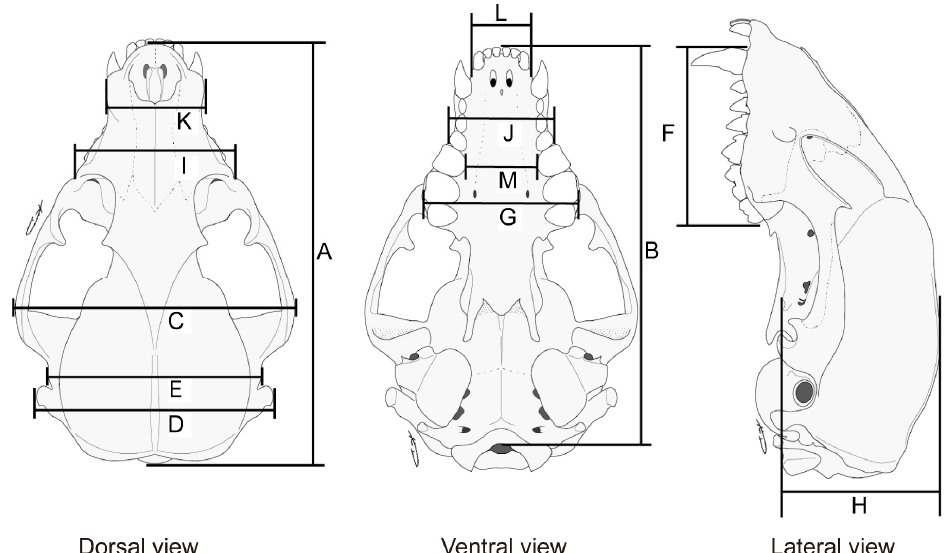
Figure 1. Lateral, ventral, and dorsal craniometrics of the raccoon ( Procyon lotor ) skull. A: greatest length of skull (GLS), B: basal length (BaL), C: zygomatic width (ZW), D: paraoccipital width (PW), E: cranial width (CW), F: length of maxillary tooth row (LMT), G: greatest width across first upper molars (M1s) (GWM), H: depth of skull (DS), I: least width between infraorbital foramen (LWIF), J: greatest width across lower third premolars (P3s) (GWP), K: rostral width (RW), L: width of incisors (WI), M: least distance between lower fourth premolars (P4s) (LDP).